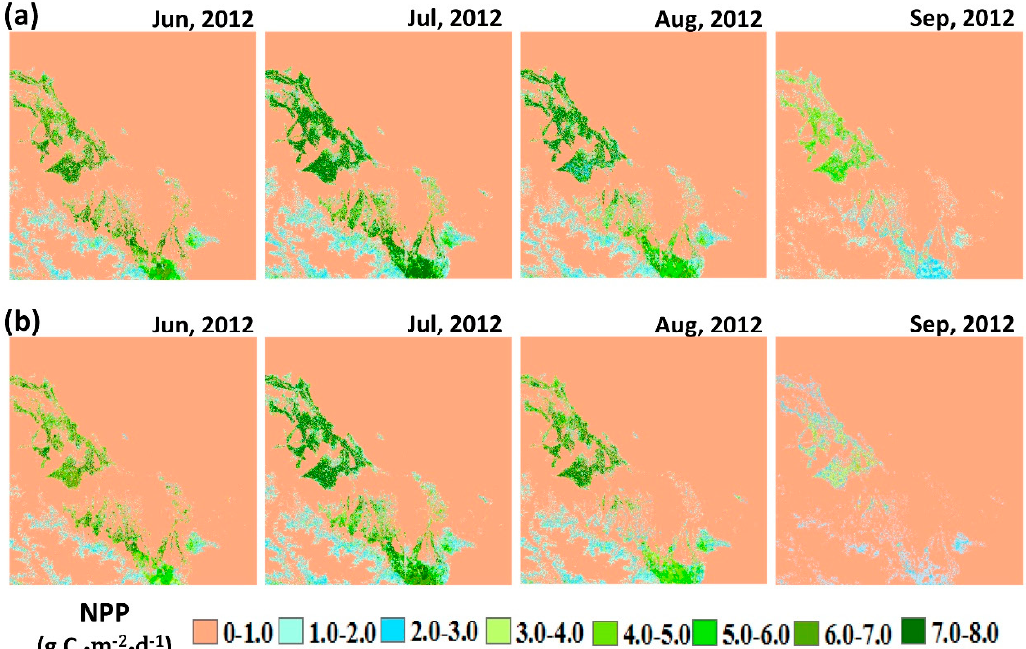
Figure 11. Spatial distribution of 30 m NPP: ( a ) D_NPP_GLASS; ( b ) D_NPP_MODIS.